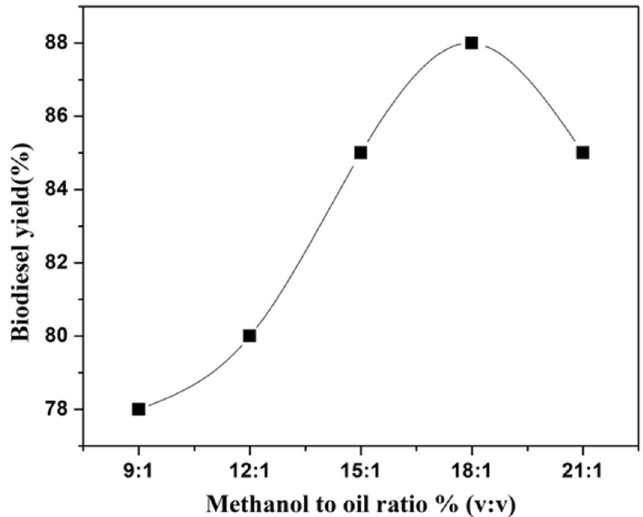
Fig. 8 Effect of methanol to oil molar ratio % (v:v) on biodiesel yield